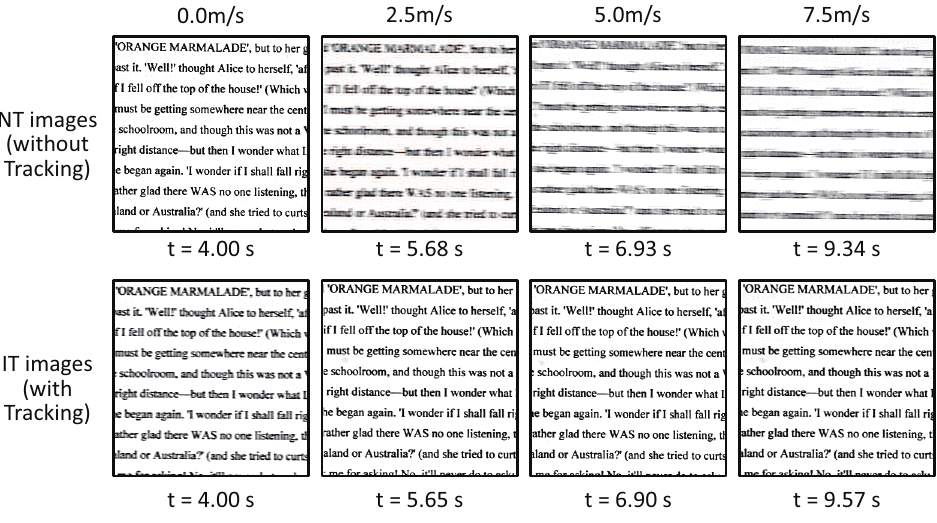
Figure 21. Images captured when the electronic board pattern moved at variable speeds.